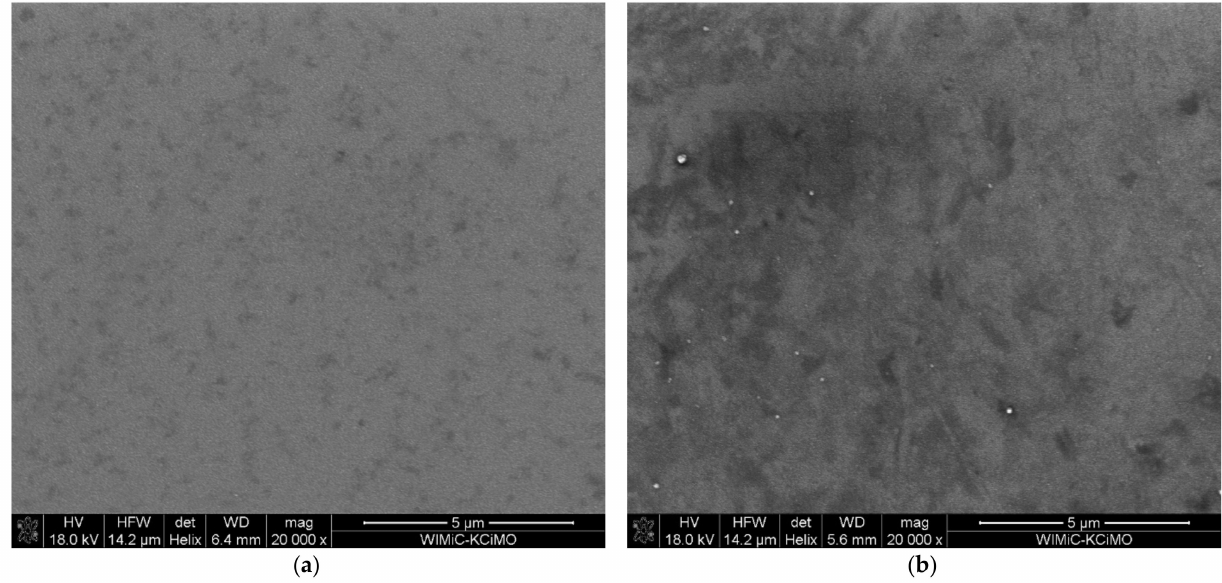
Figure 6. SEM images of sample ( a ) S1-Si-130 at 20,000 × magnification, ( b ) S2-Si-130-dose3-10 at 20,000 ×